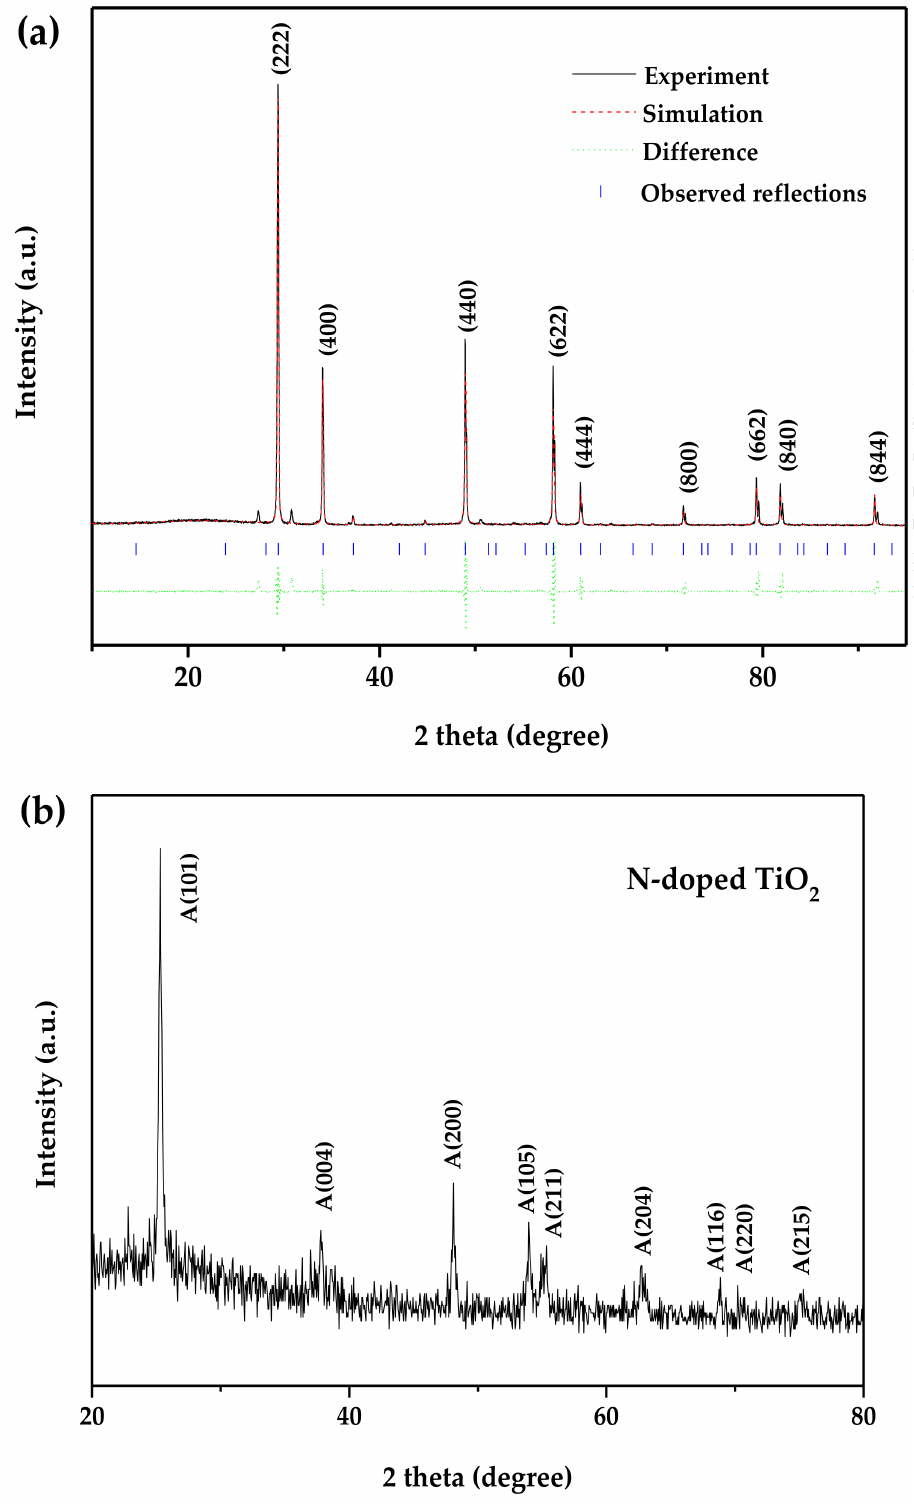
Figure 3. ( a ) The Pawley refinement outcomes of XRD data for BiSnSbO 6 ; ( b ) XRD spectrum of N-doped TiO 2 . The light absorption near the band edge for a crystalline semiconductor was found according to the following equation [52,53]: α h ν = A(h ν − E g ) n , where A, α , E g and ν were proportional constant, absorption coefficient, band gap and light frequency, respectively. Within this equation, the